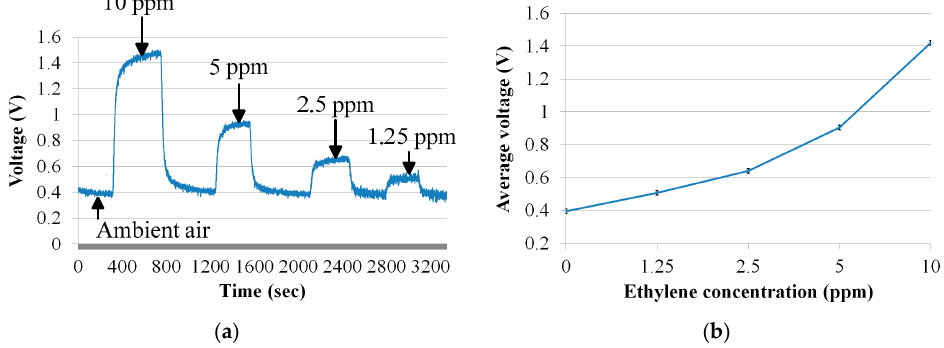
Figure 4. ( a ) Electrochemical sensor response at ambient air, 10 ppm, 5 ppm, 2.5 ppm, and 1.25 ppm; ( b ) the relationship between the concentration of ethylene and the output voltage.